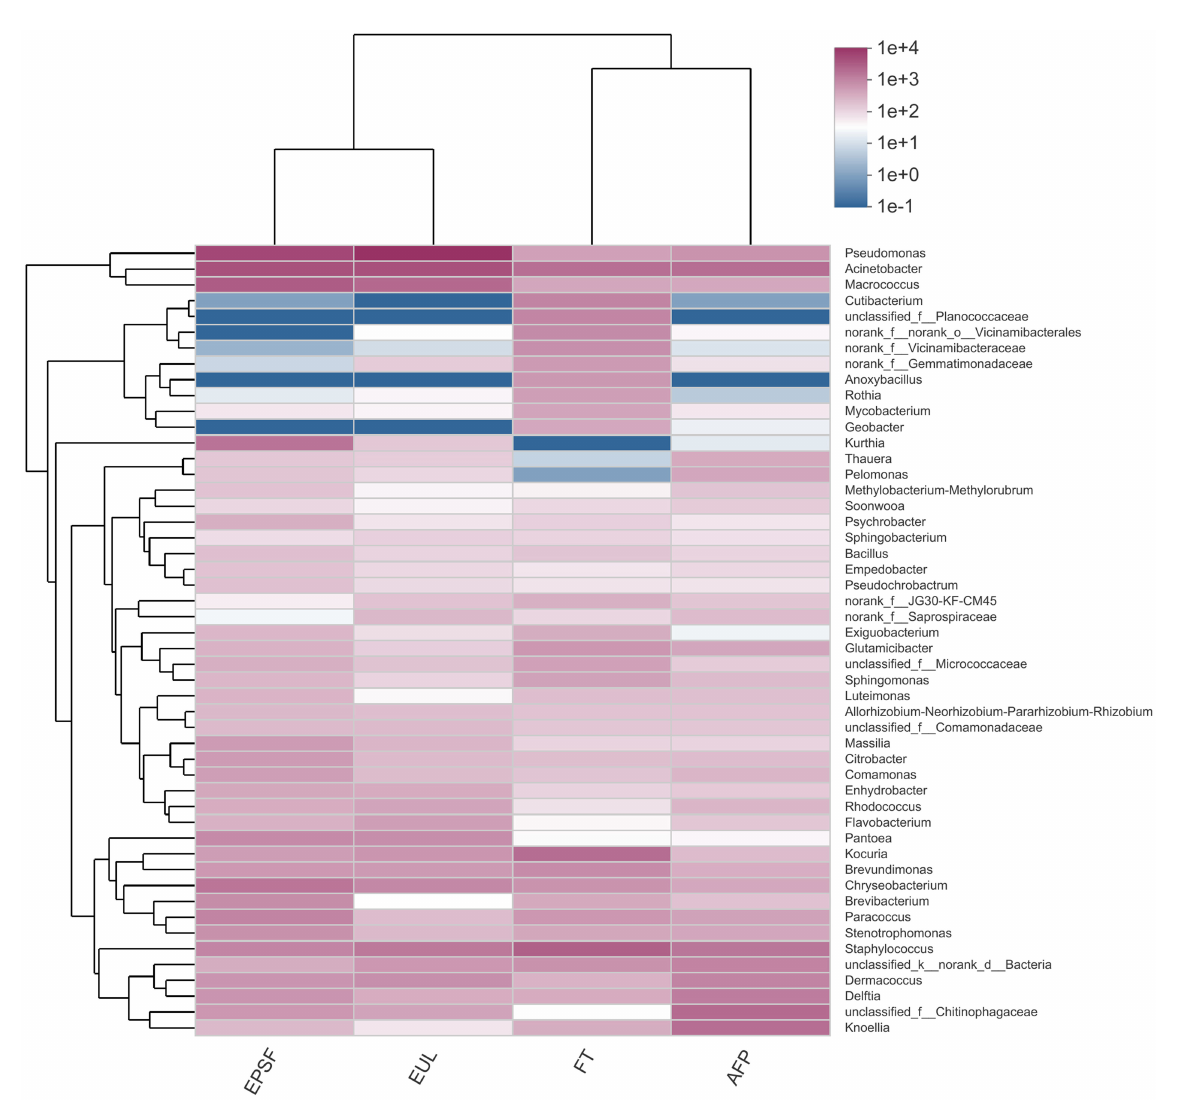
FIGURE7 Clustering heat map of microbial abundance at the genus level in bigeye tuna muscle transported by various logistics packaging boxes. FT, fresh tuna; EUL, European logistics; EPSF, expanded polystyrene foam; AFP, aluminum foil paper.